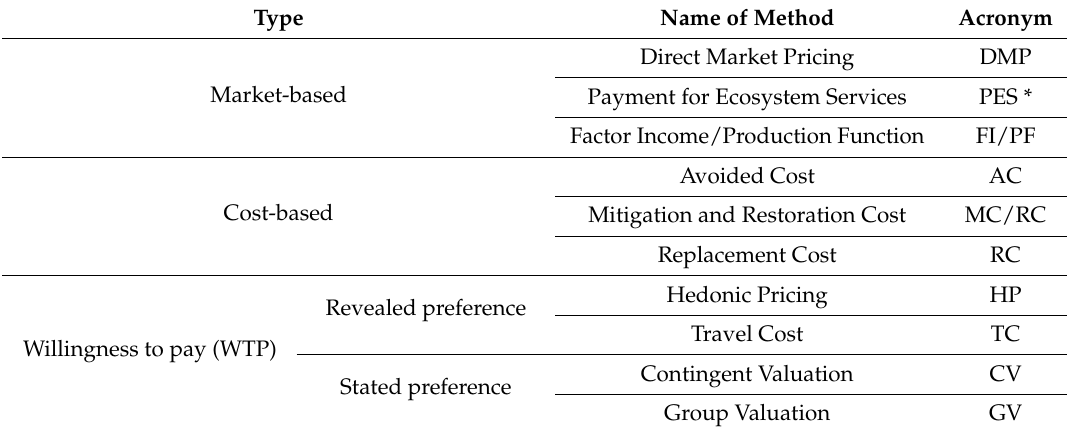
Table 1. Classification of ecosystem service valuation methods